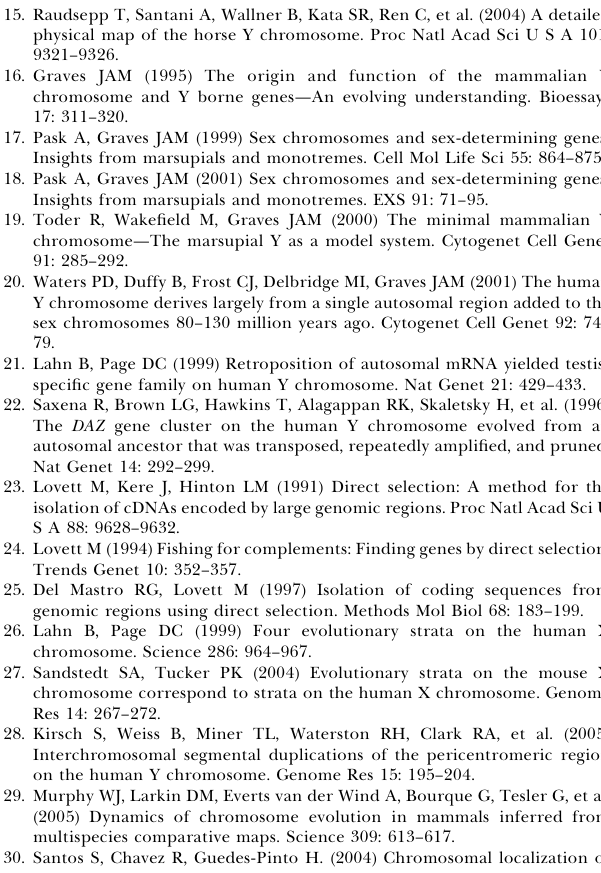
Figure S1. Genomic Mapping of Feline Autosomal FLJ36031 to Feline Chromosome A2 Found at DOI: 10.1371/journal.pgen.0020043.sg001 (128 KB PDF). Figure S2. Multispecies Alignment and Phylogeny of TETY1 and Orthologous Human (Hsa), Canine (Cfa), and Feline Autosomal Genome Fragments Found at DOI: 10.1371/journal.pgen.0020043.sg002 (102 KB PDF). Figure S3. Alignments of TETY2 Homologs to Canine and Human X Chromosomes Found at DOI: 10.1371/journal.pgen.0020043.sg003 (264 KB PDF). Figure S4. Evidence for a CUL4BY Genomic Fossil on Human (left) and Chimpanzee (right) Y Chromosomes Found at DOI: 10.1371/journal.pgen.0020043.sg004 (93 KB PDF).